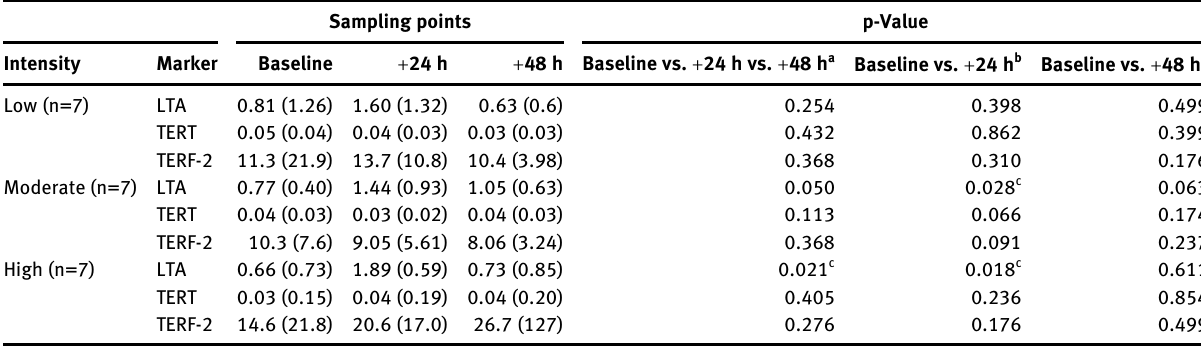
Table  : Median (IQR) results of leukocyte telomerase activity (TA, ‰ per cell), telomerase reverse transcriptase (TERT) expression and telomericrepeat bindingfactor  (TERF-  ) expressionbefore andafter  min of cyclingexercise ona stationarybicycleergometer at different intensities. TERT and TERF-  results are non-dimensional (relative to